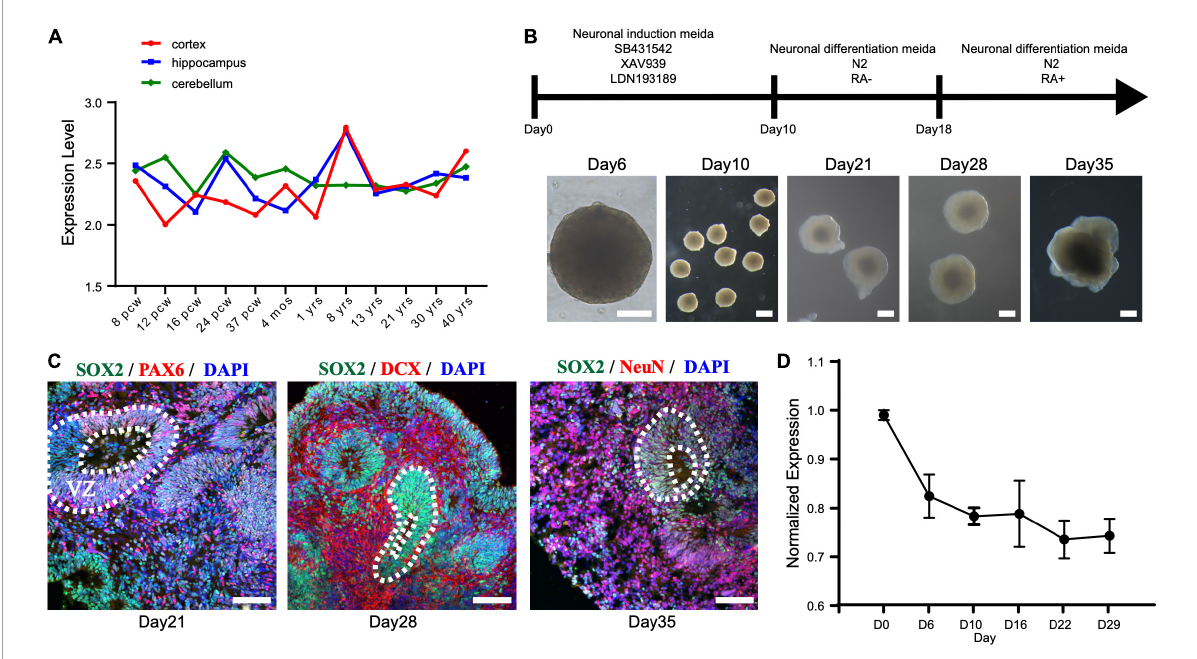
FIGURE3 STAMBP expression during human cortical development. (A) STAMBP expression in the human cortex, hippocampus, and cerebellum. Data were downloaded from Allen Brain Atlas (available from: http://www.brain-map.org; Ensemble ID: ENSG00000124356). pcw, post-conceptional weeks; mos, months; yrs, years. (B) Schematic representation of the culture system described in detail in Section “Patient and methods.” Examples of each stage are shown. Scale bars, 200 µ m. (C) Immunofluorescent staining of hCOs of day 21 for neural stem cell markers Left column: SOX2, PAX6, and DAPI; middle column: SOX2, DCX, and DAPI; right column: SOX2, NeuN, and DAPI. Scale bars, 100 µ m. (D) STAMBP mRNA expression in the different differentiated stages of hCOs. Mean ± SEM from three independent